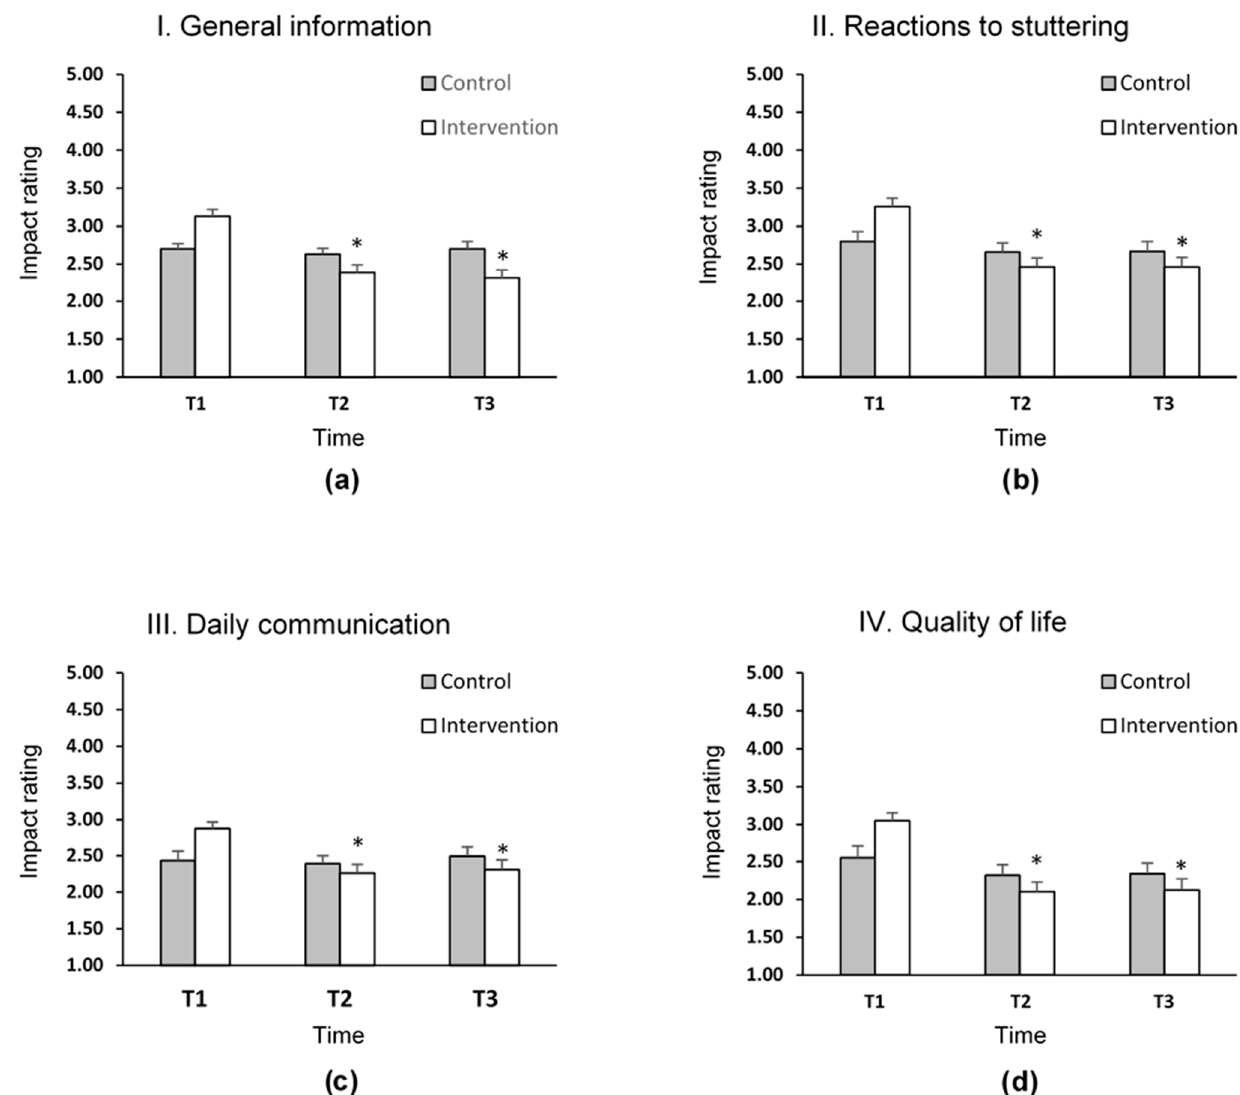
Figure 4. Effect of IBSR intervention on the four sections of Overall Assessment of the Speaker’s Experience of Stuttering-Adults (OASES-A) in comparison to control group. ( a ) OASES-A-I. General information: describes general perspectives about stuttering such as perceived fluency, speech naturalness and knowledge about stuttering ( b ) OASES-A-II. Reactions to stuttering: illustrates speaker’s affective, behavioral and cognitive reactions to stuttering ( c ) OASES-A-III. Daily communication: presents the speaker's degree of difficulty in various daily communication situations ( d ) OASES-A-IV. Quality of life: describes how much stuttering affects the speaker’s quality of life. Data are displayed as mean score + standard deviation. * p < 0.05. T1 = before intervention, T2 = after intervention, and T3 = one month after intervention. Impact rating score rates the severity of the stuttering experience: mild (1.00–1.49), mild–moderate (1.50–2.24), moderate (2.25–2.99), moderate–severe (3.00–3.74), and severe